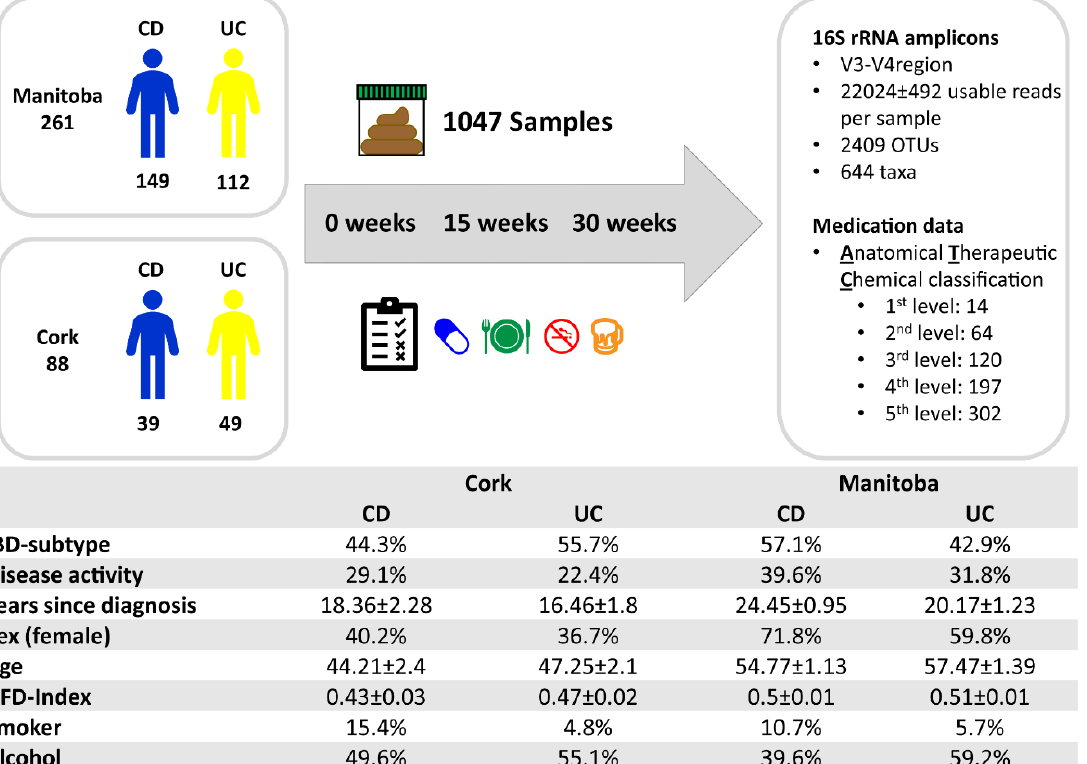
Figure 1. Subject characteristics and sample sizes of the study cohort. The ATC classification system classifies medications hierarchically based on the therapeutic use of the main active ingredient: 1st level: anatomical main group; 2nd level: therapeutic subgroup; 3rd level: pharmacological subgroup; 4th level: chemical subgroup; 5th level: chemical substance.